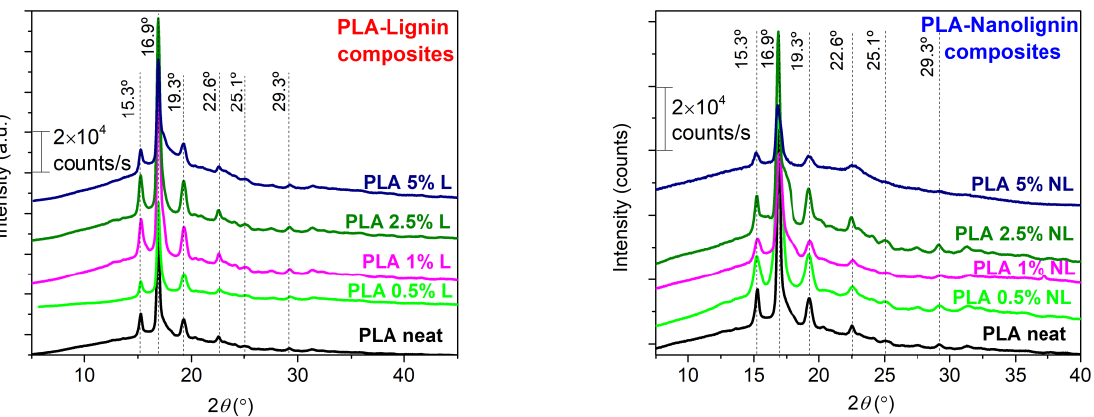
Figure 8. XRD results are shown comparatively for neat PLA and PLA–Lignin/Nanolignin composites that underwent isothermal crystallization annealing at 115 °C overnight.